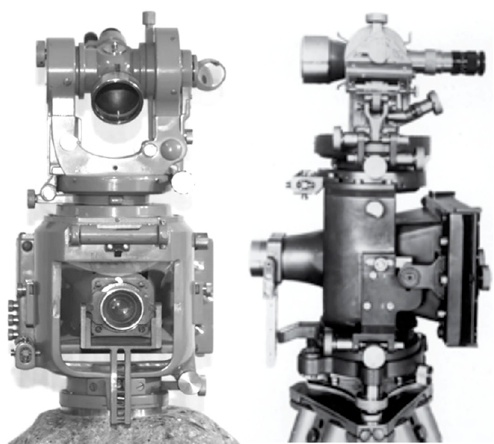
Figure 3. Wild photo theodolites P30 ( left ) and FT9 ( right ) [20].